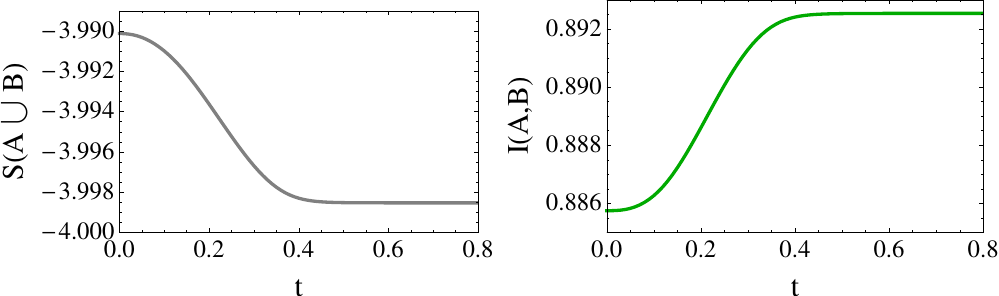
Figure 25 . (Left) Renormalized entanglement entropy of A [ B as a function of time. (Right) Mutual information of A and B as a function of time. We consider a system with d = 3 within the linearized background of refs. [96, 97], with the same con(cid:12)guration as in (cid:12)gure 24. cf. eq. (3.13), appears to be a robust property valid also for d = 3, and the same can